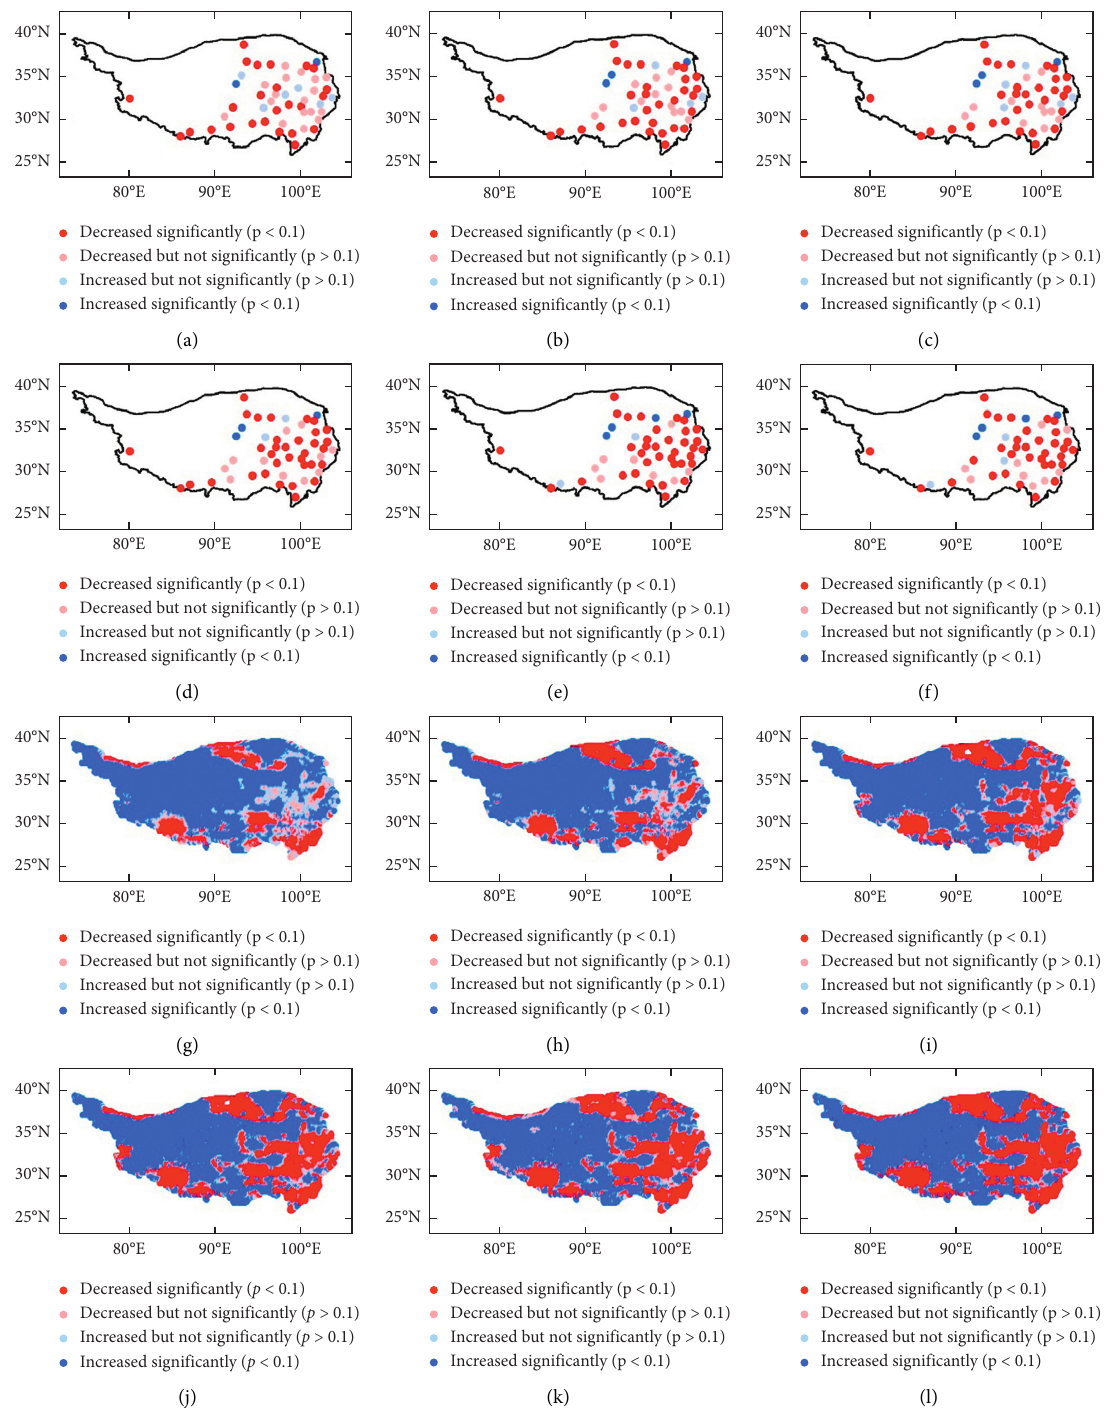
Figure 2: Spatial distributions of the Mann–Kendall trend statistic for SPEI at different time scales for the period 1979–2015. (a)–(f) are the SPEI trends based on observed data, and (g)–(l) are the SPEI trends based on the CMFD data. (a) SPEI-1. (b) SPEI-3. (c) SPEI-6. (d) SPEI-9. (e) SPEI-12. (f) SPEI-24. (g) SPEI-1. (h) SPEI-3. (i) SPEI-6. (j) SPEI-9. (k) SPEI-12. (l)